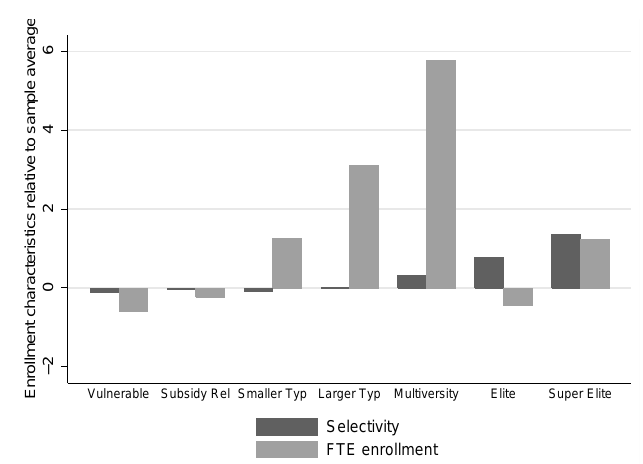
Figure 1. Financial characteristics of the seven profiles.